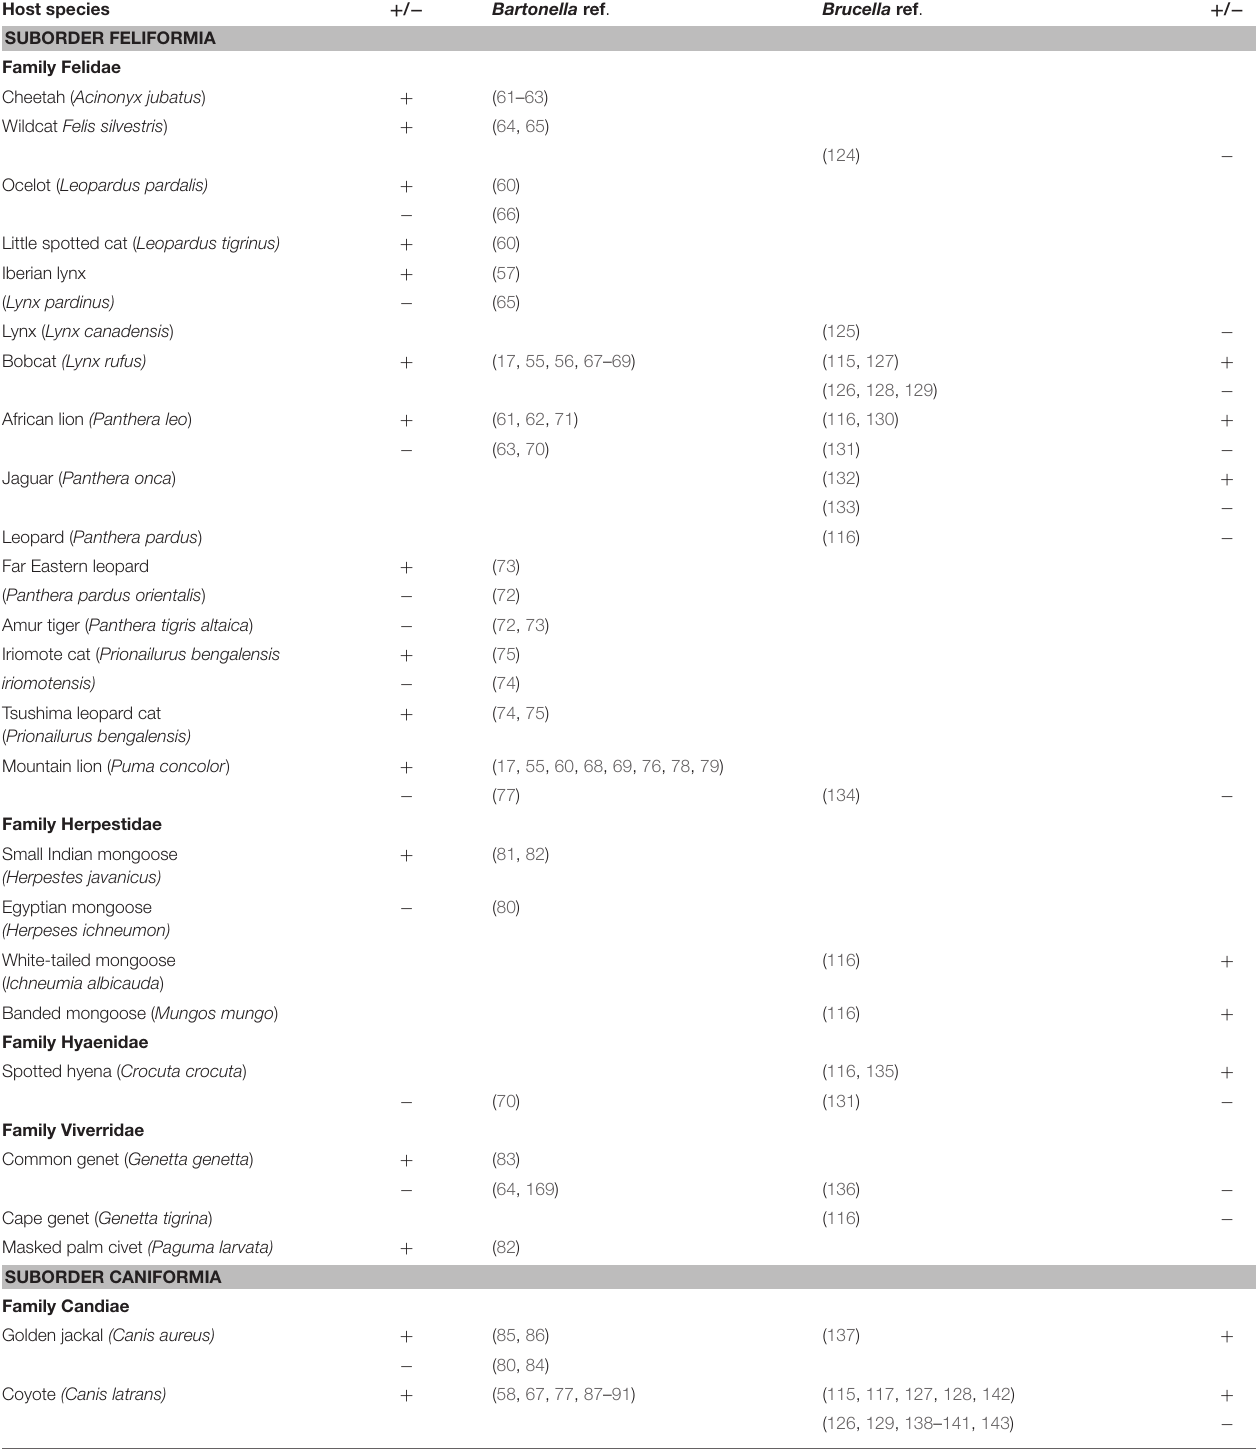
TABLE 3 | Bartonella and Brucella studies in wild carnivores by